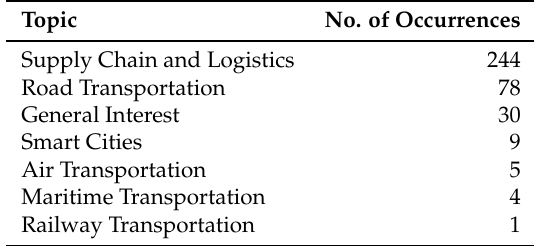
Table 4. Results of the manual categorization on the 371 documents selected.